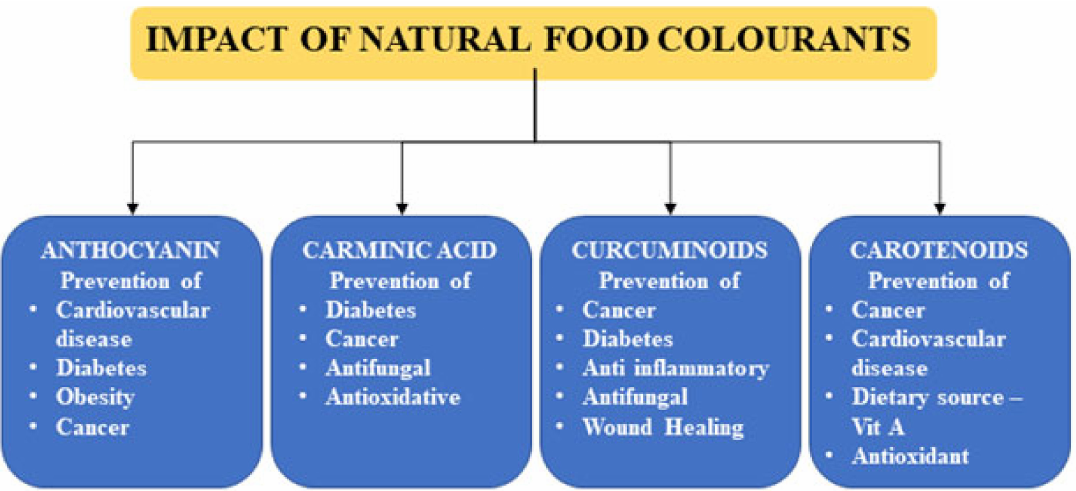
Figure 1. Beneficial effects of natural food colorants on human